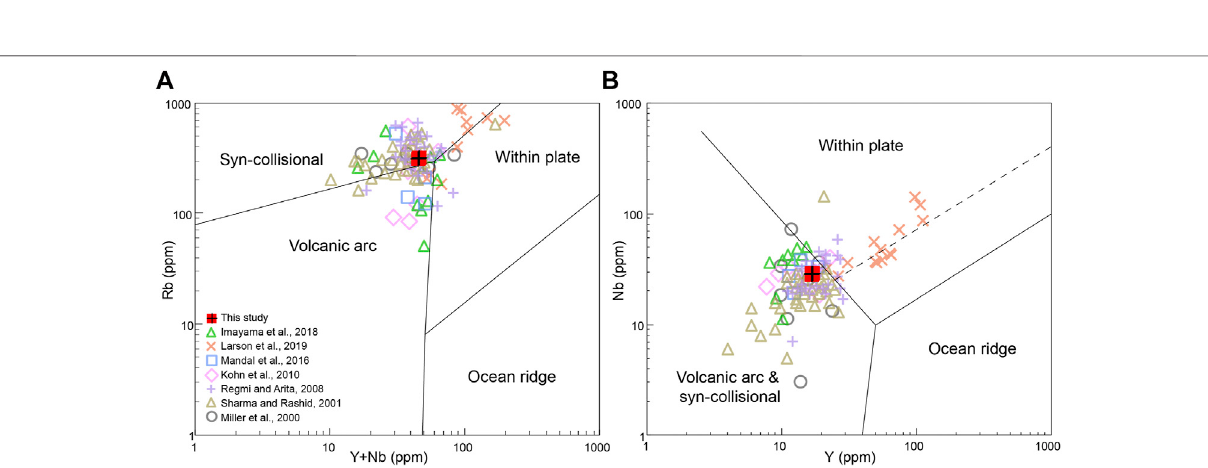
U contents, and negative Sr anomalies.